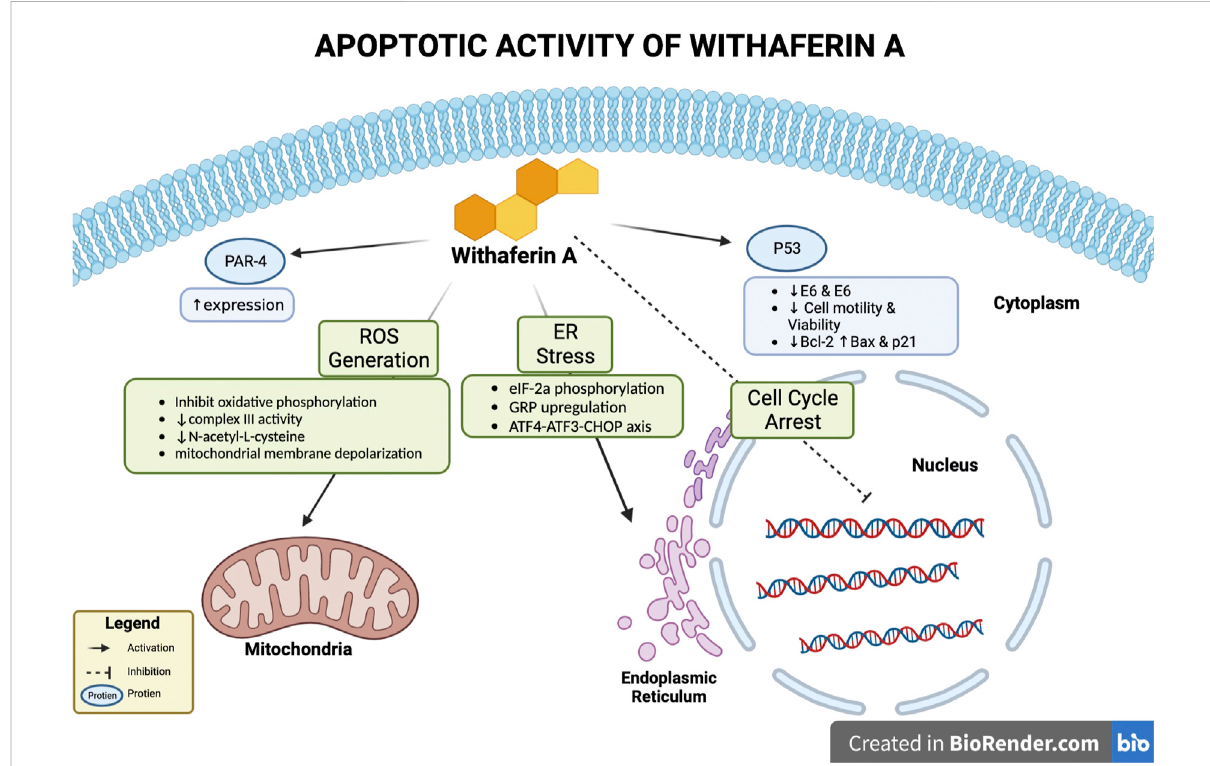
FIGURE 2 Apoptotic activity of Withaferin A. Withaferin A ’ s apoptotic activity can occur through various interactions with intercellular components/ proteins.Theseincludeactivation ofPar-4 toincrease itsexpression,activation ofp53,endoplasmicreticulum (ER)stressinduction,cell cyclearrest, and interaction with mitochondria to generate reactive oxidative species